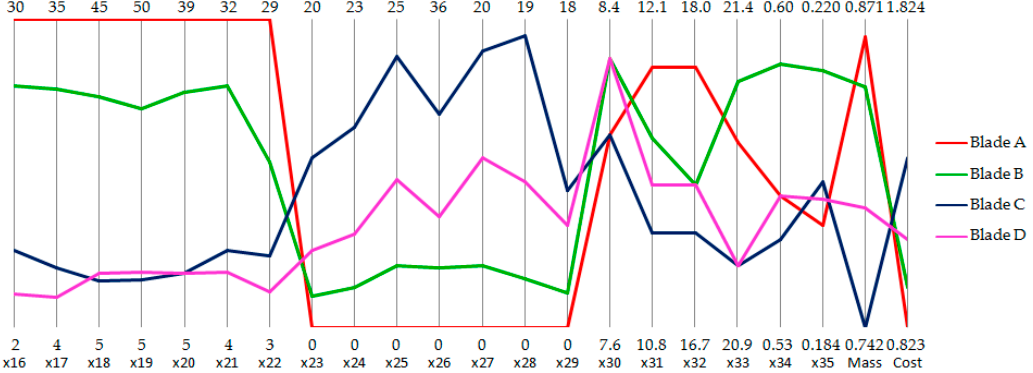
Figure 21. Structural variables of the extreme point design in parallel coordinates.